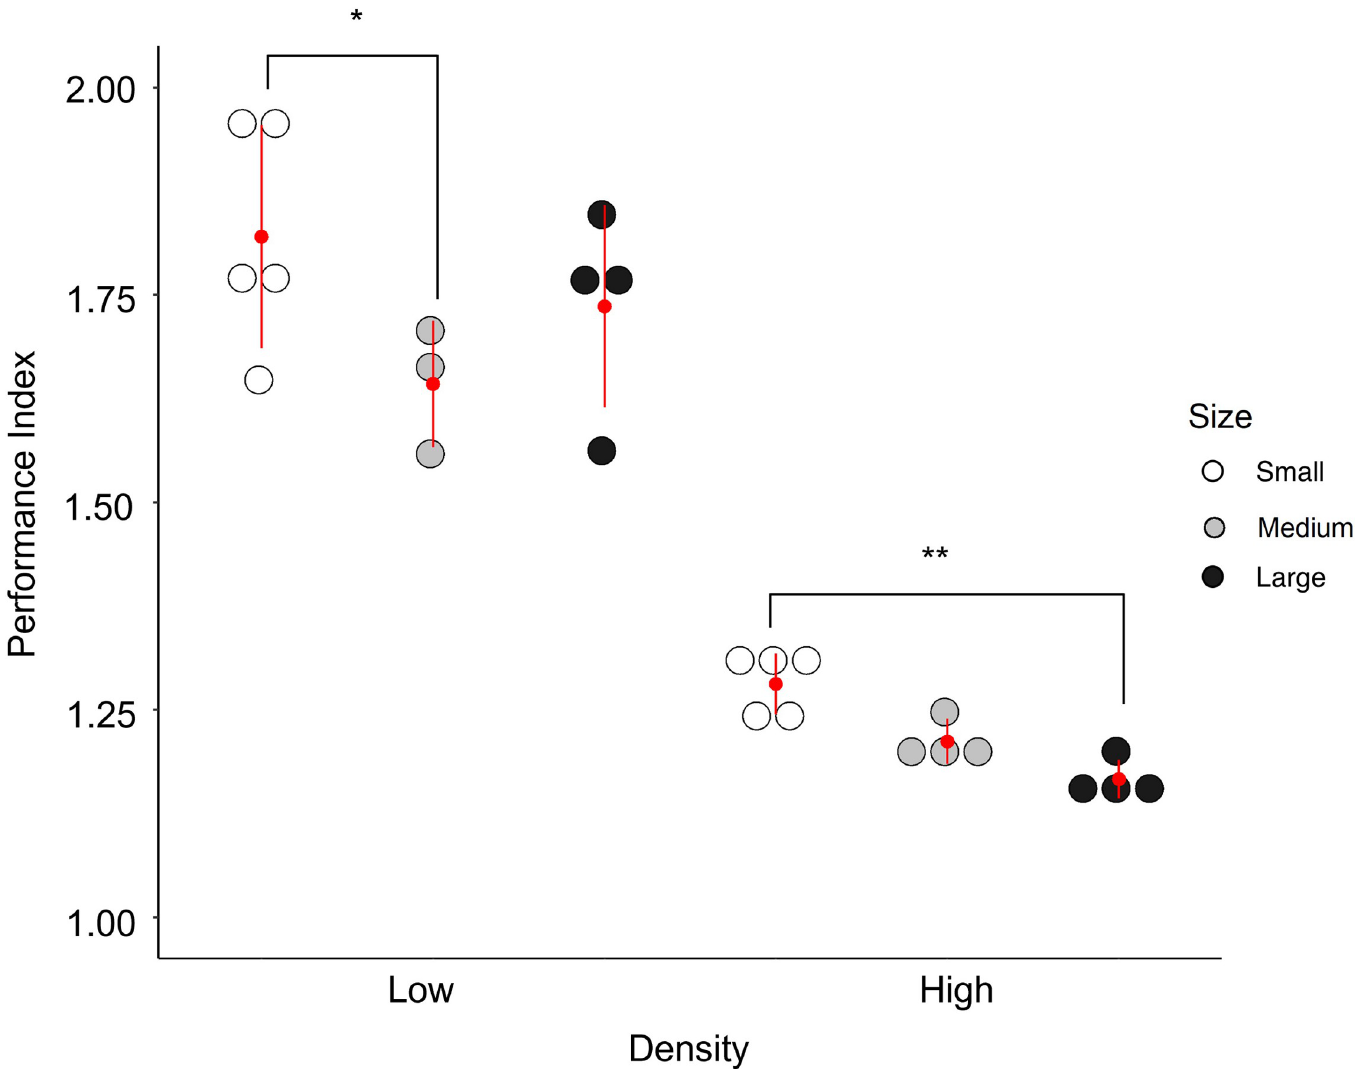
Fig 5. Productivity for each container size and density. The individual points represent the productivity for each replicate with the red dot representing the mean productivity for that treatment (n = 4–5 trays/treatment). The red line either side of the mean represents ± 1